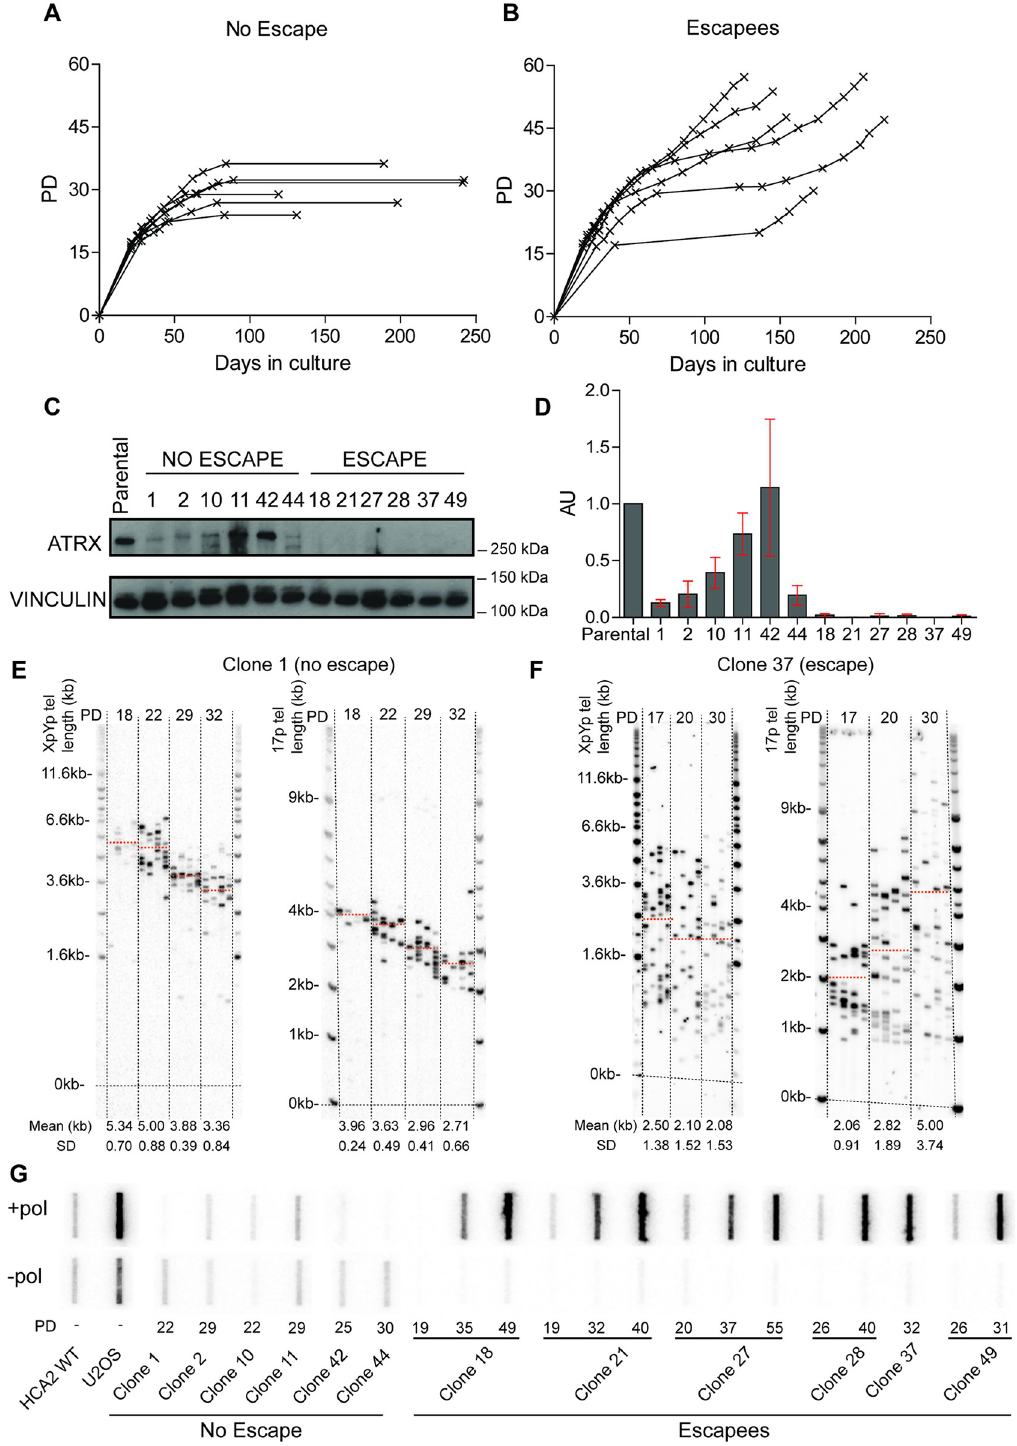
Fig 1. ALT upregulation and maintenance in the absence of ATRX in primary fibroblasts undergoing a telomere-driven “crisis”. Growth curves displaying PDs graphed against days in culture for (A) HCA2 HPVE6E7 clones (n = 6) that failed to escape crisis and (B) HCA2 HPVE6E7 clones (n = 6) that successfully escaped crisis. (C) Western blots displaying ATRX protein expression in “no escape” and “escape” clones with vinculin expression used as a loading control. (D) Quantification of the ATRX protein expression using the ATRX:vinculin ratio normalised to the parental cell line expressed in arbitrary units (AU)